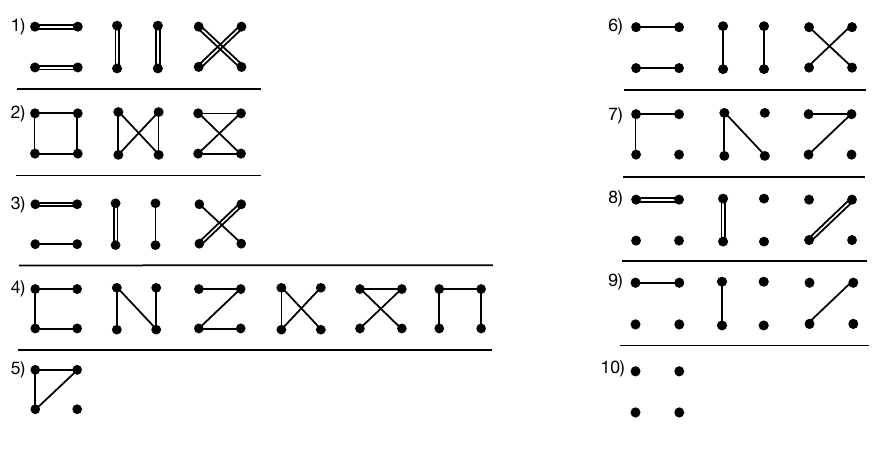
Figure 2 . Parity even index structures of 4-graviton